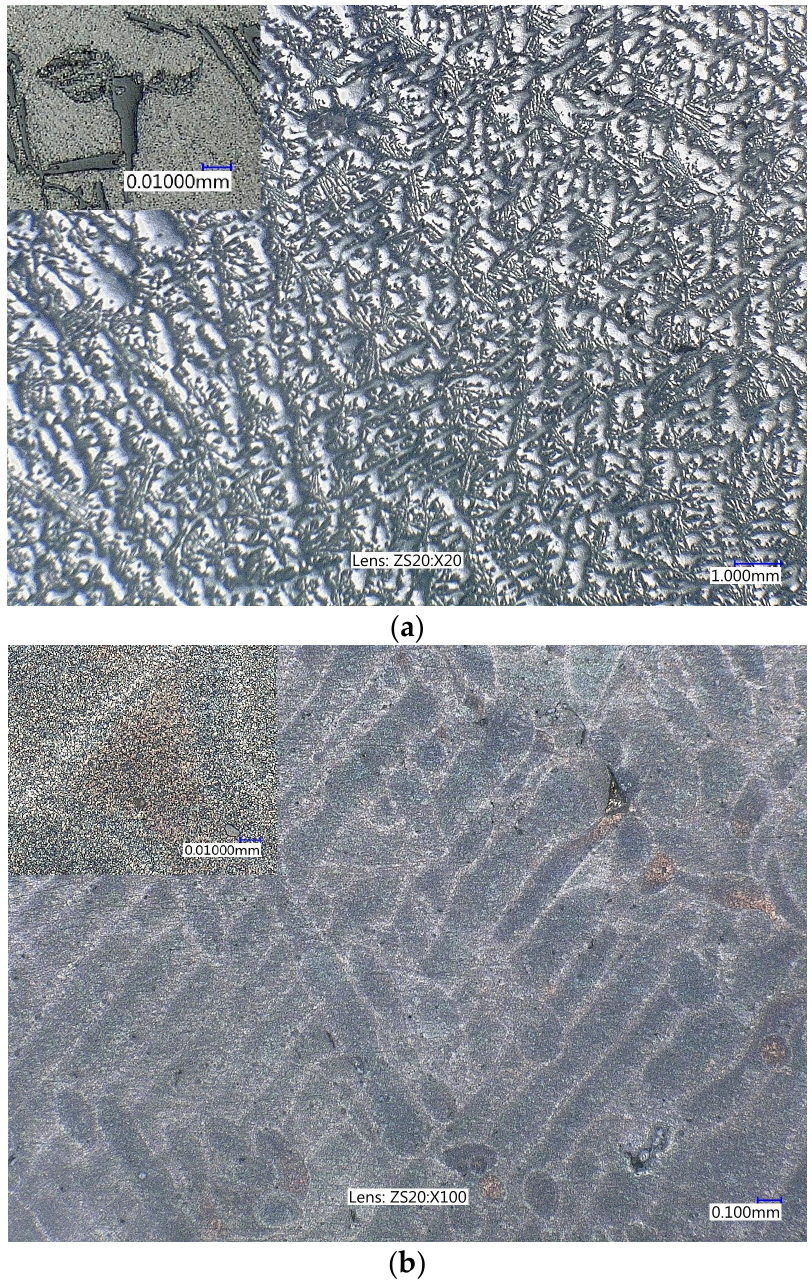
Figure 1. Microstructure of AlSi 10 Mg: ( a ) conventional casting, ( b ) AM technology. Etched in Hypofluorous acid (HF) and 10% sodium hydroxide (NaOH).